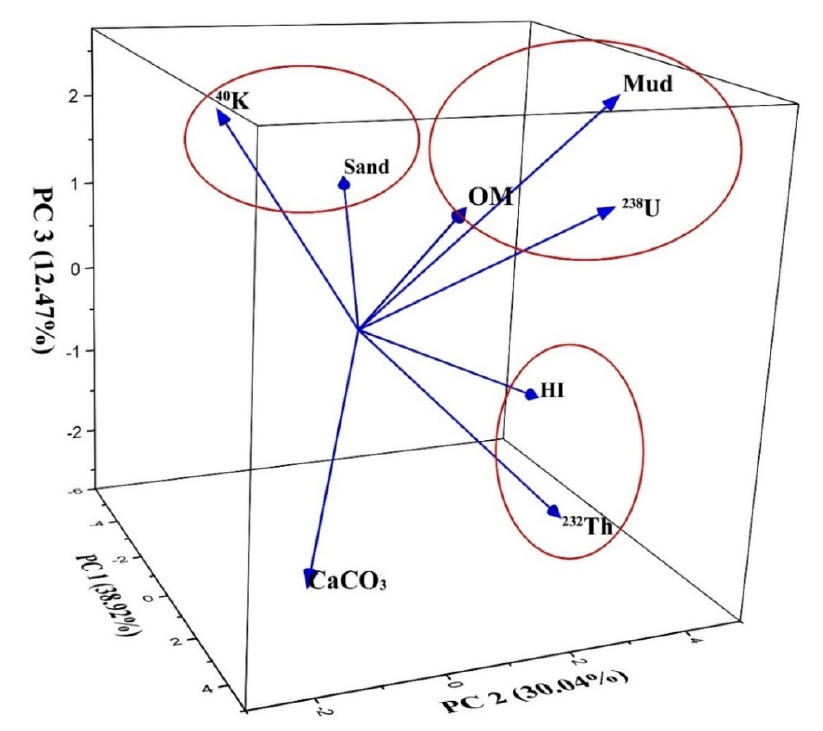
Figure 7. PCA variable 3D loading.